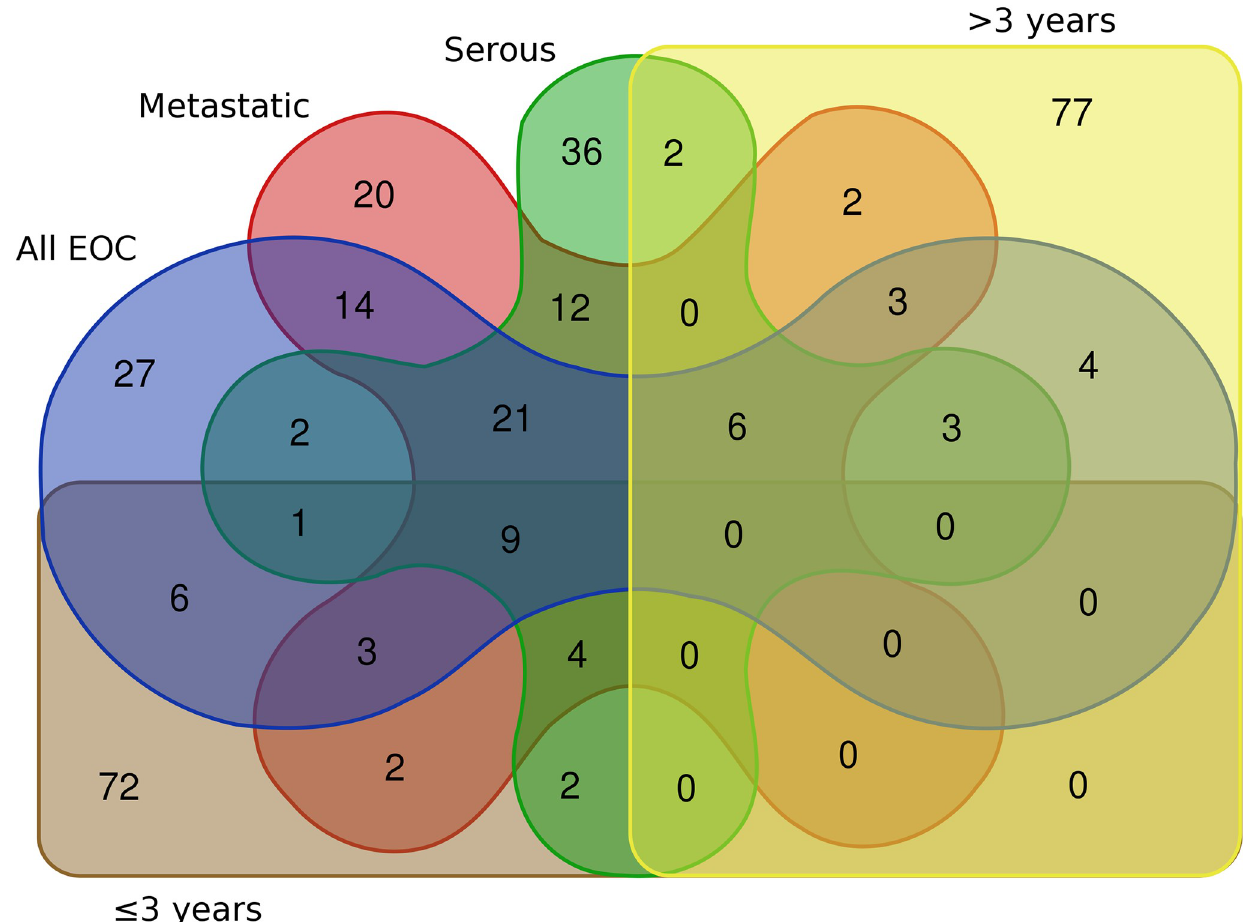
Fig 2. Overlap between the 100 probes with lowest p-values in single-gene linear models (case-control) of prospective blood samples from all cases of epithelial ovarian cancer (EOC; 66 pairs) and subgroups (metastatic at diagnosis (56 pairs), serous subtype (45 pairs), or interval to diagnosis ( � 3 years or > 3 years; 34 and 31 pairs, respectively)). The 100 probes are listed in S2–S6 Tables. (Created with BGE Venn diagram tool, Ghent University).